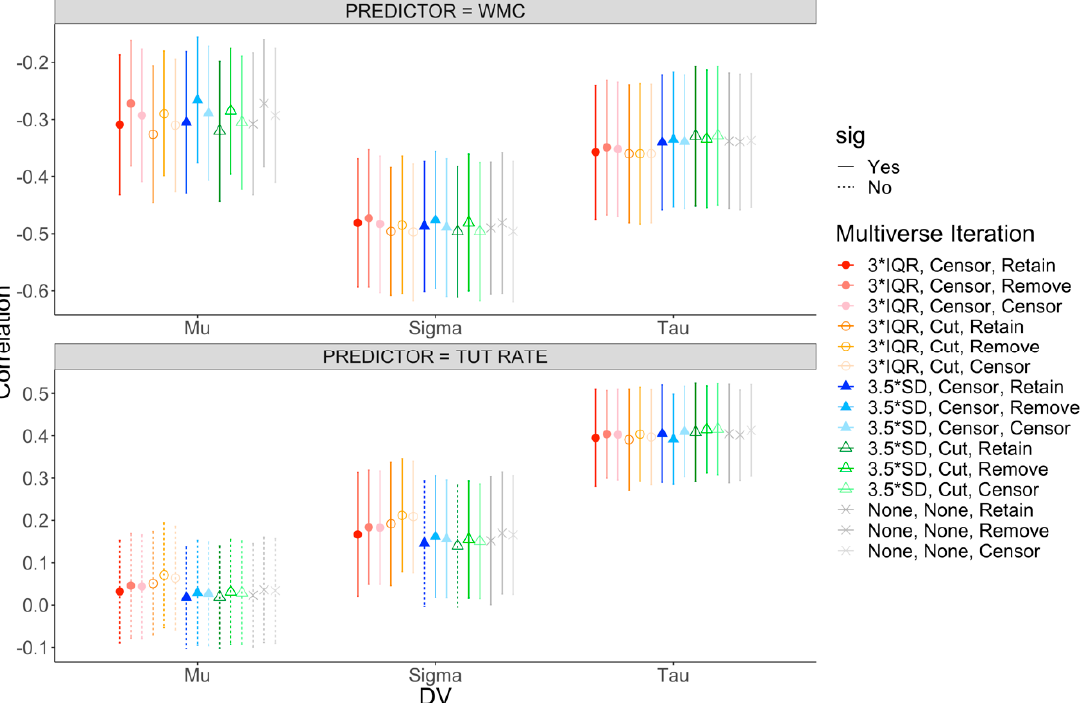
Figure 3. Solid CIs represent significant correlations, and dashed CIs represent non-significant correlations at p = 0.05.